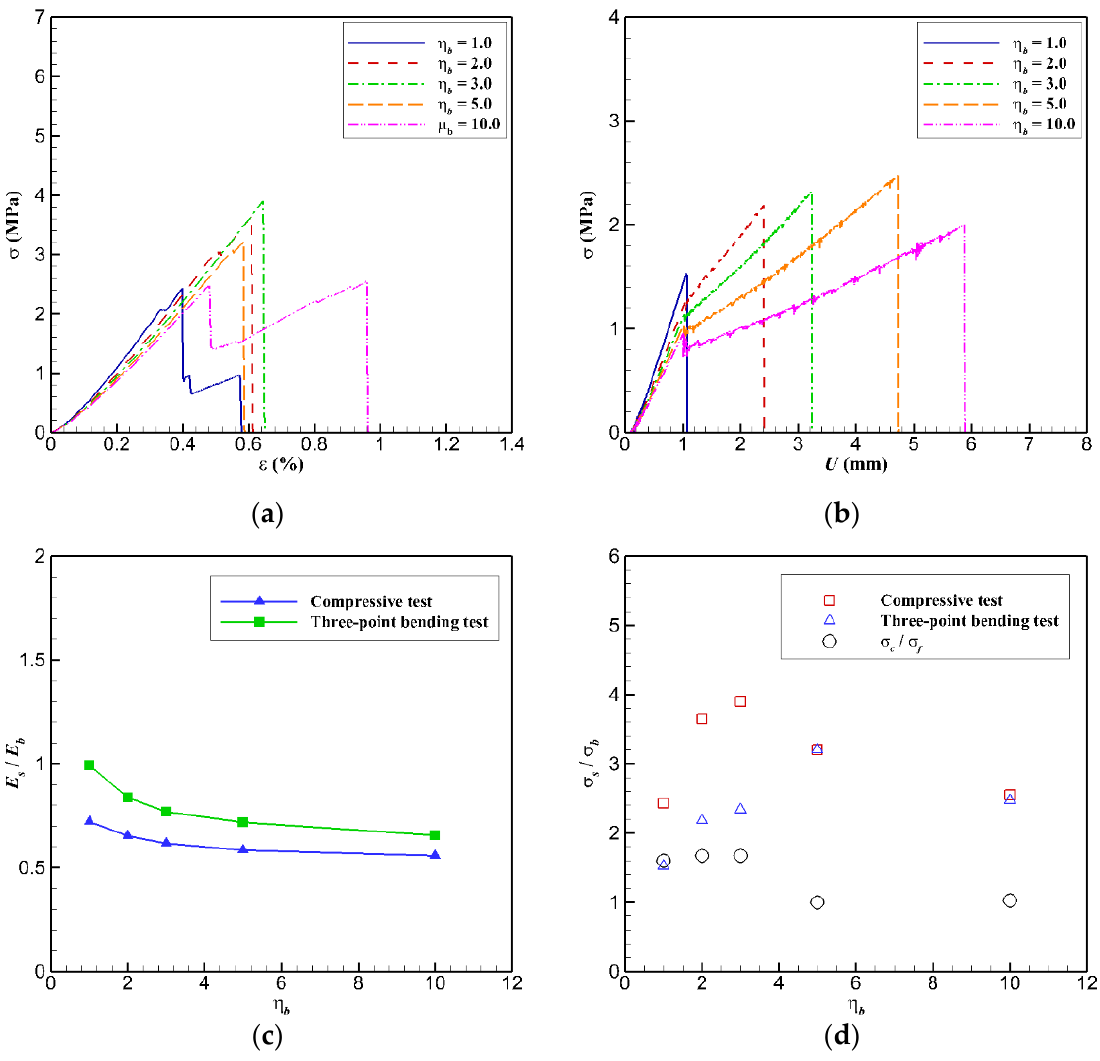
Figure 16. Effect of bond stiffness ratio of the normal and tangential components ( η b ): ( a ) stress–strain curve; ( b ) stress–deflection curve; ( c ) effect of bond stiffness ratio on the ratio of simulated Young’s modulus to bond Young’s modulus; ( d ) ratio of simulated strength to bond strength.